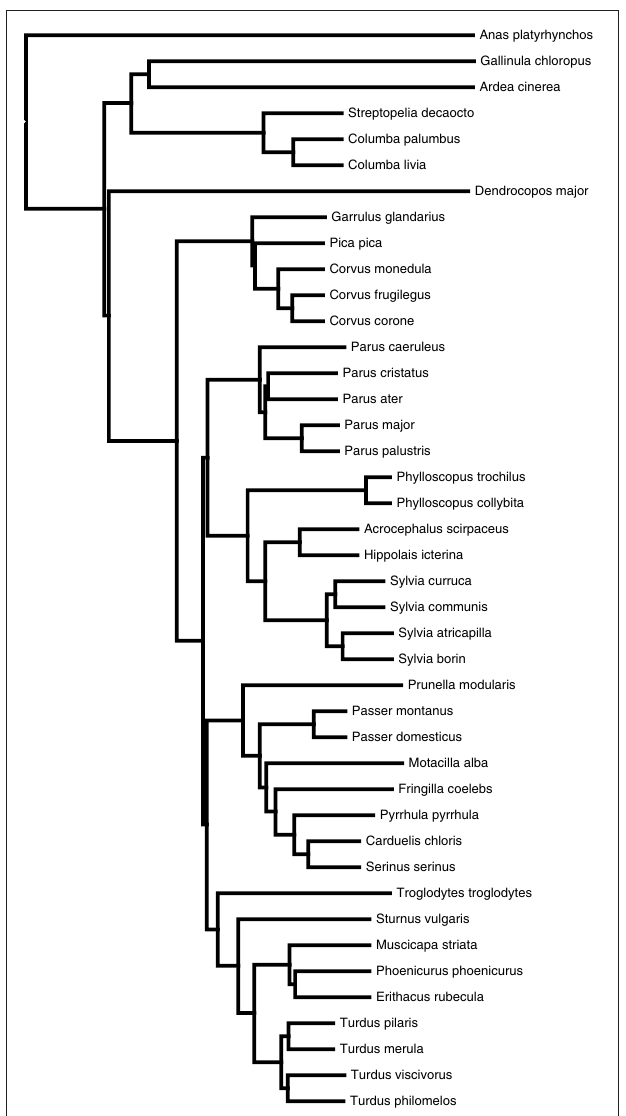
FIGURE 2 | Consensus phylogeny for the 42 bird species in the